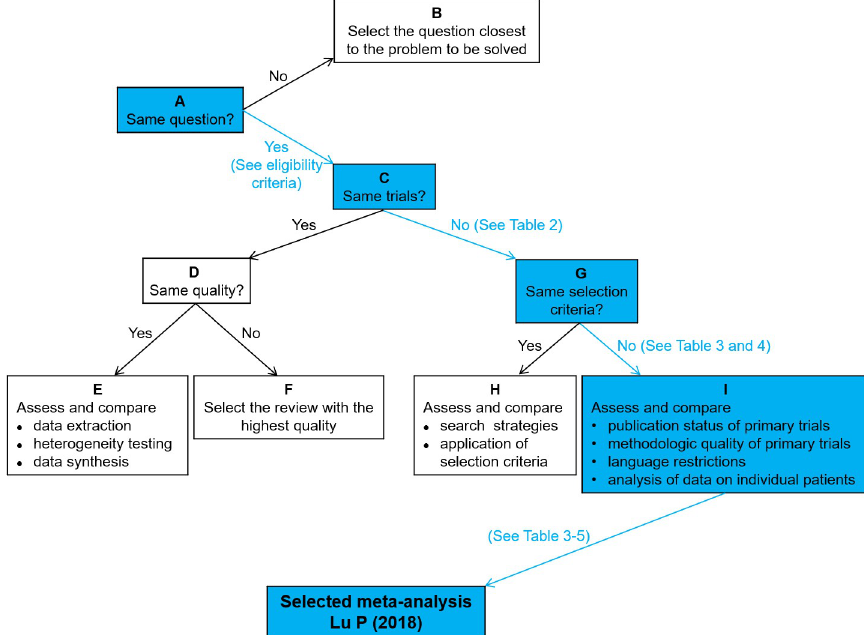
Fig 3. The flowchart of Jadad decision